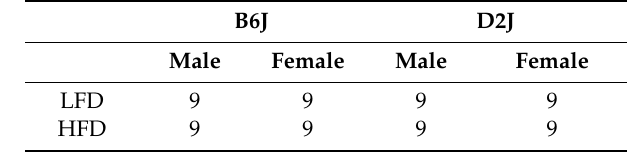
Table 1. Study design based on strain, sex, and